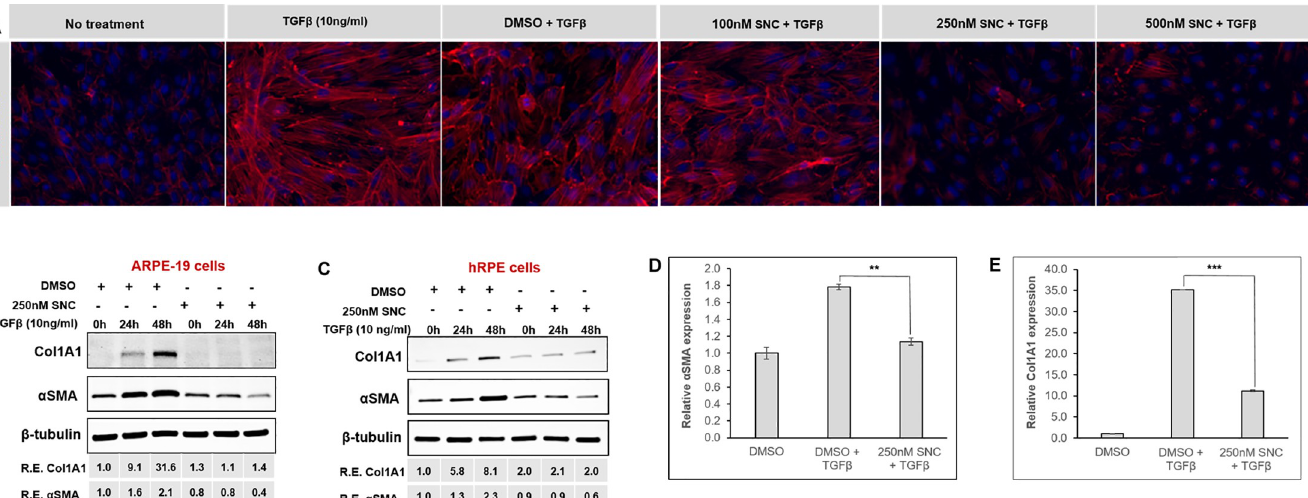
PLOS ONE | https://doi.org/10.1371/journal.pone.0222596 September 17,